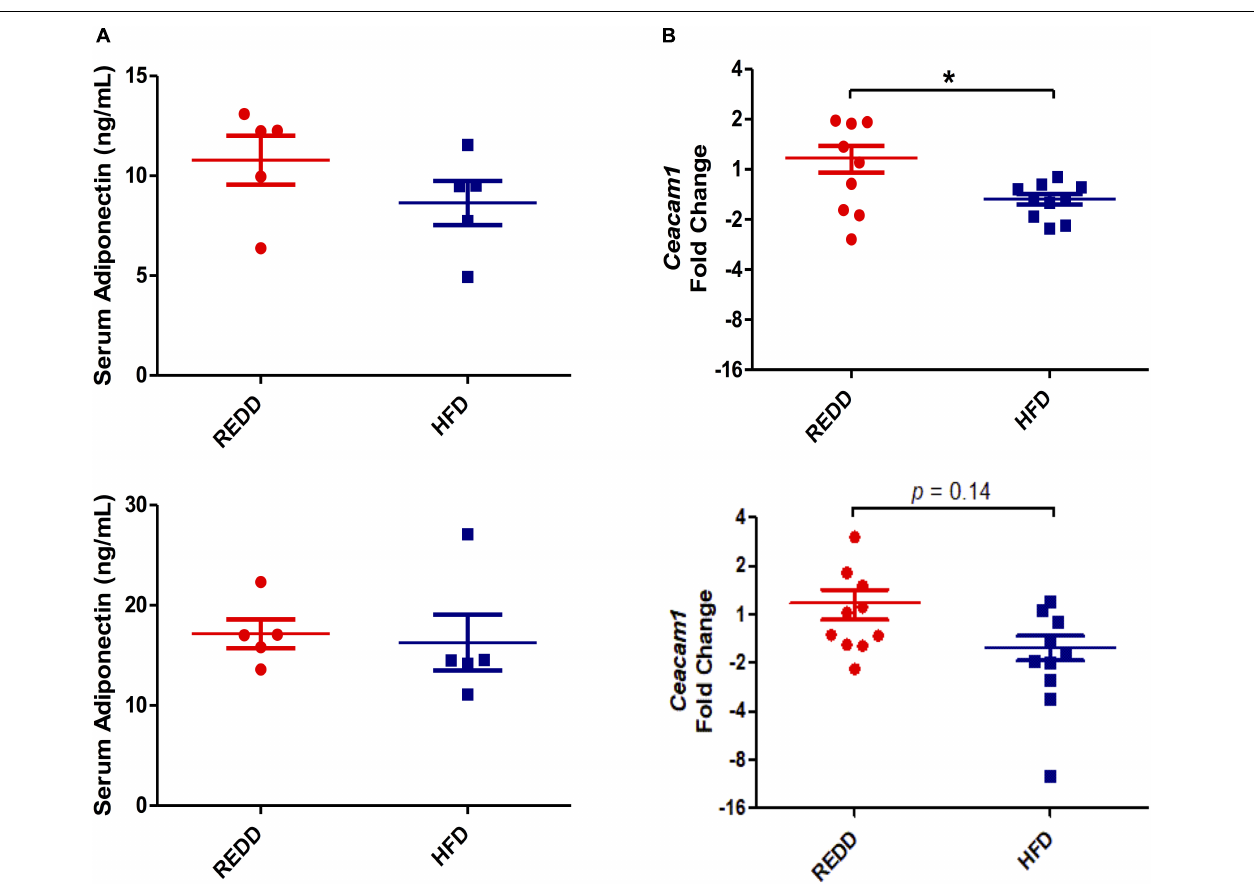
FIGURE 4 | HFD alters insulin signaling. (A) Quantification of serum adiponectin levels via ELISA for male (top) and female (bottom). (B) Hepatic Ceacam1 gene expression quantified by qRT-PCR for male (top) and female (bottom). Rplp0 expression was used as an internal standard. Results are expressed as Log 2 (Fold Induction) with repression values (i.e., < 1) expressed as its negative reciprocal (i.e., 0.5 = − 2). Numerical data are summarized as means ± SEM. ∗ p < 0.05. REDD, reduced energy density diet; HFD, high fat